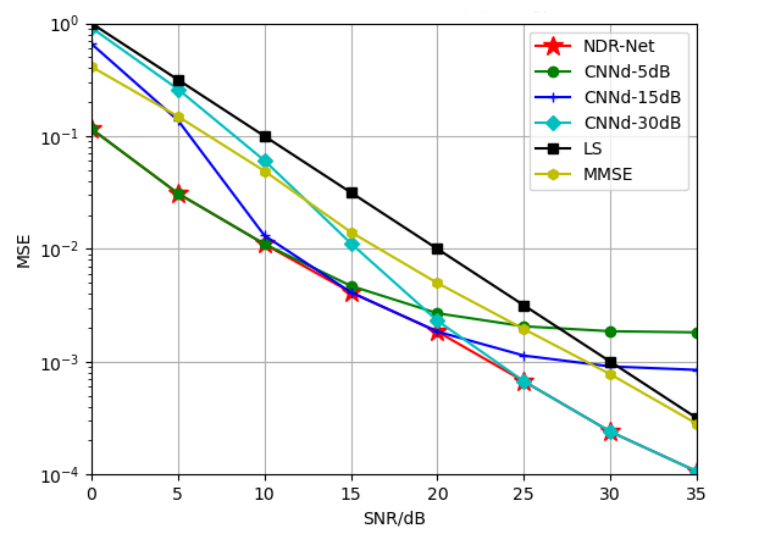
Figure 5. Generalization performance of the trained channel estimator with different SNR for the test channel